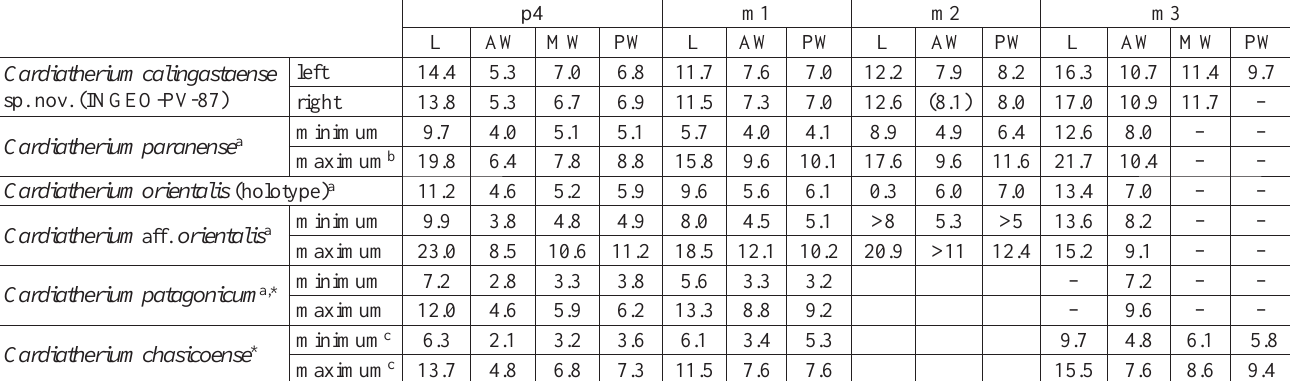
Table 4. Comparison of lower tooth dimensions (in mm) of Cardiatherium . a minimum and maximum values after Vucetich et al. (2005); b values correspond to the holotype MLP 40-XI-15-1; c values after Deschamps et al. (2009), a very small m1/2 of Cardiatherium patagonicum was not here considered; * m1–m2 not differentiated; AW, anterior width; L, length; MW, medium width; PW, posterior width; approximate values in